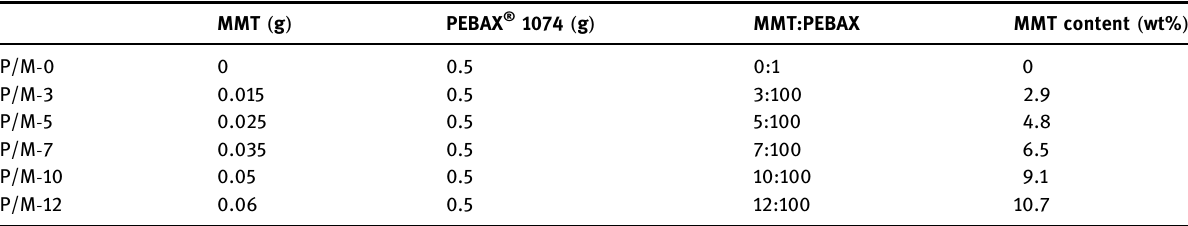
Table 1: Composition of MMT/PEBAX® 1074 membrane